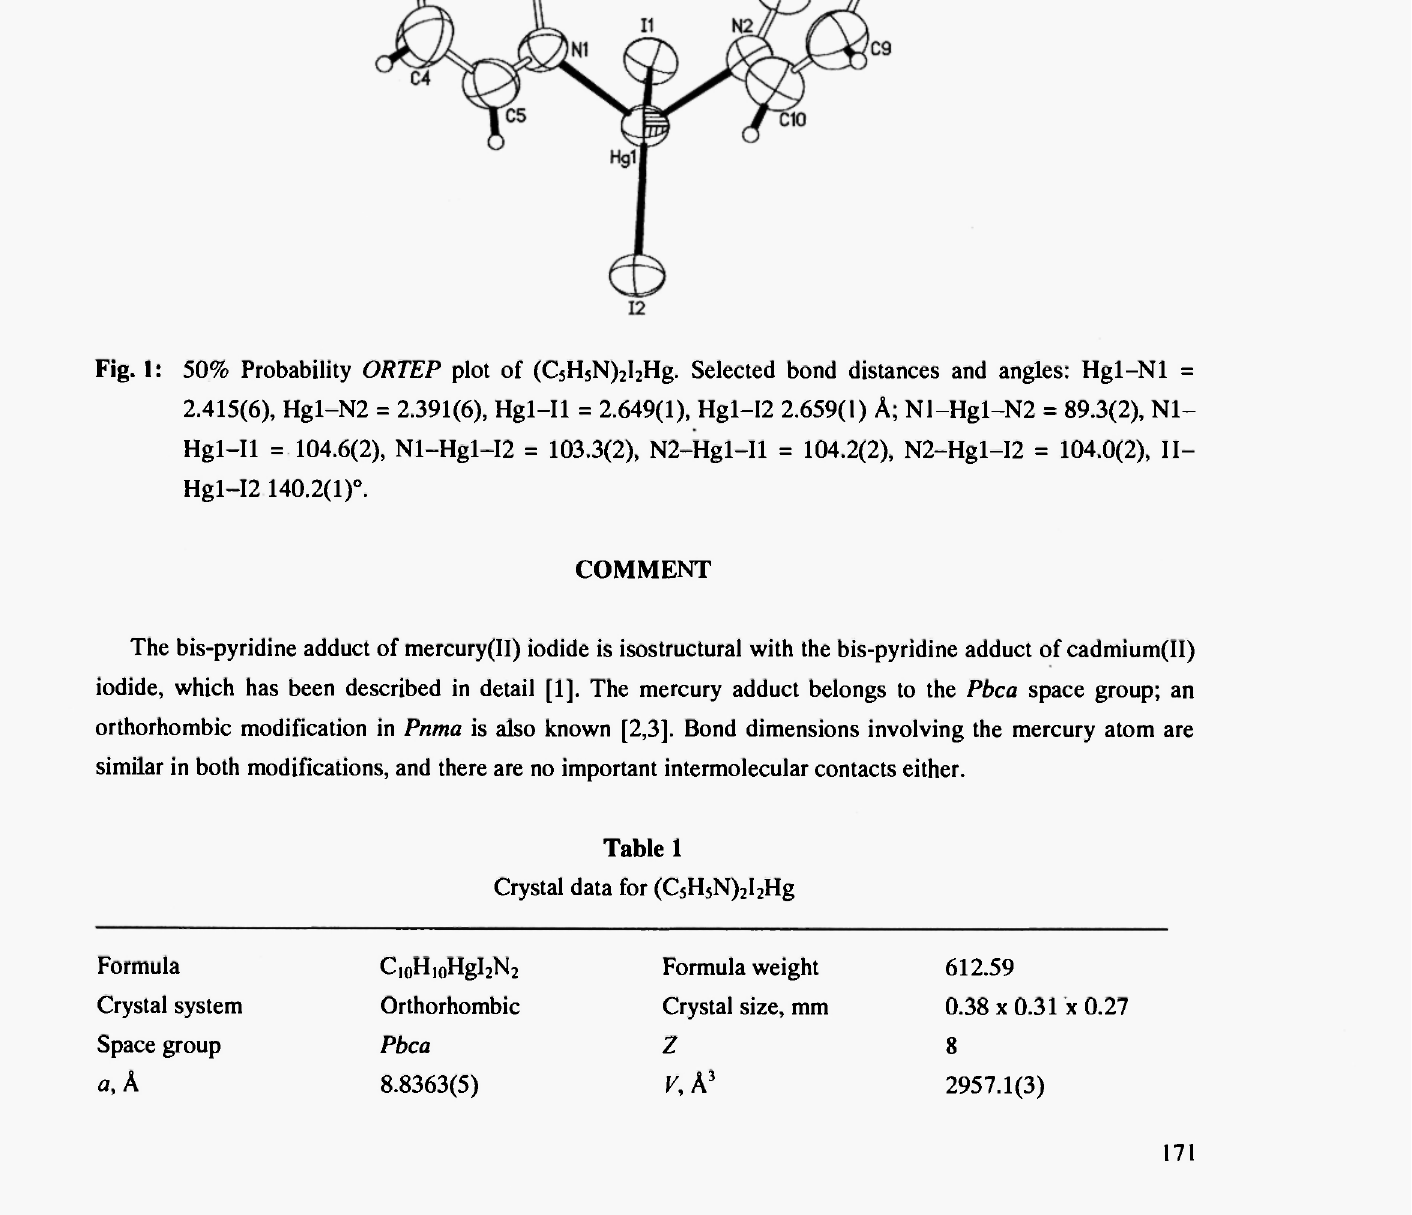
Fig. 1: 50% Probability ORTE Ρ plot of (C 5 H 5 N) 2 I 2 Hg. Selected bond distances and angles: Hgl-Nl = 2.415(6), Hgl-N2 = 2.391(6), Hgl-Il = 2.649(1), Hgl-I2 2.659(1) A; Nl-Hgl-N2 = 89.3(2), N l- Hgl-Il = 104.6(2), Nl-Hgl-I2 = 103.3(2), N2-Hgl-Il = 104.2(2), N2-Hgl-I2 = 104.0(2), II- Hgl-I2